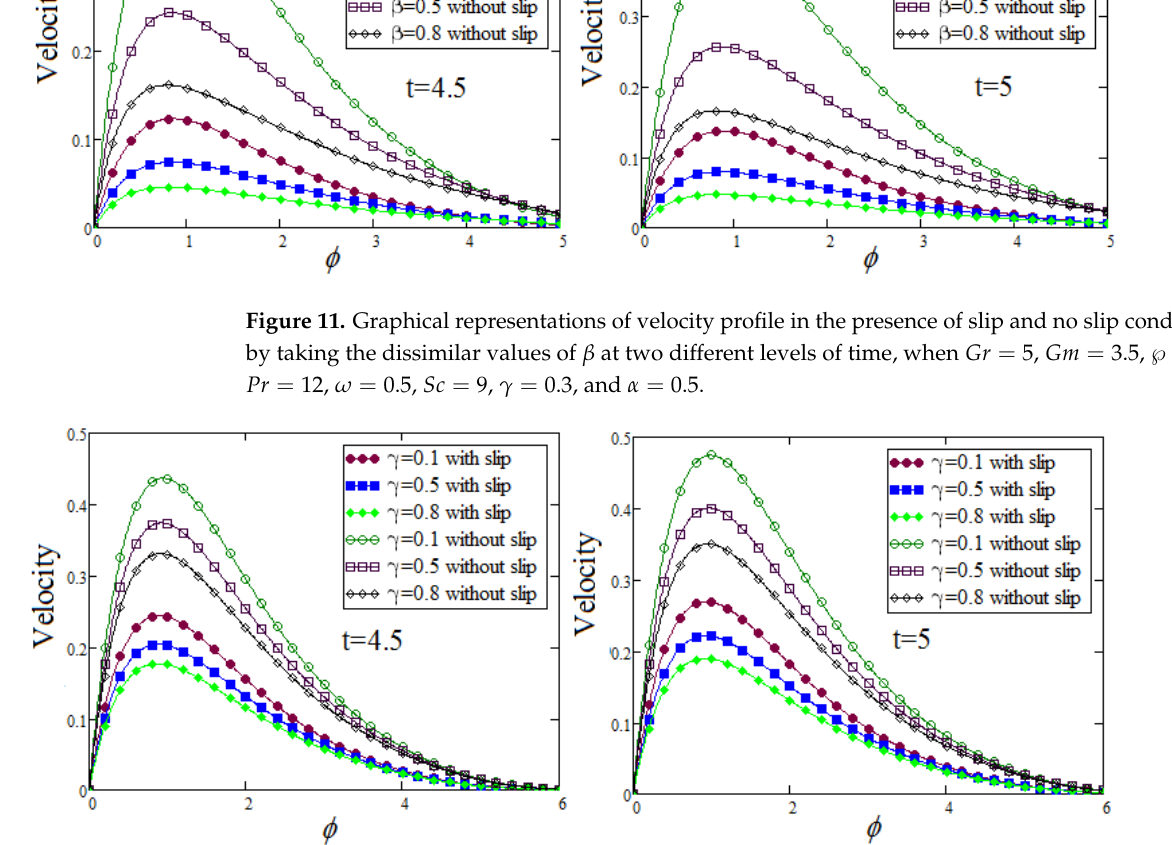
Figure 12. Graphical representations of velocity profile in the presence of slip and no slip conditions by taking the dissimilar values of γ at two different levels of time, when Gr = 5, Gm = 3.5, ℘ = 0.4, Pr = 12, ω = 0.5, Sc = 9, β = 0.3, and α =